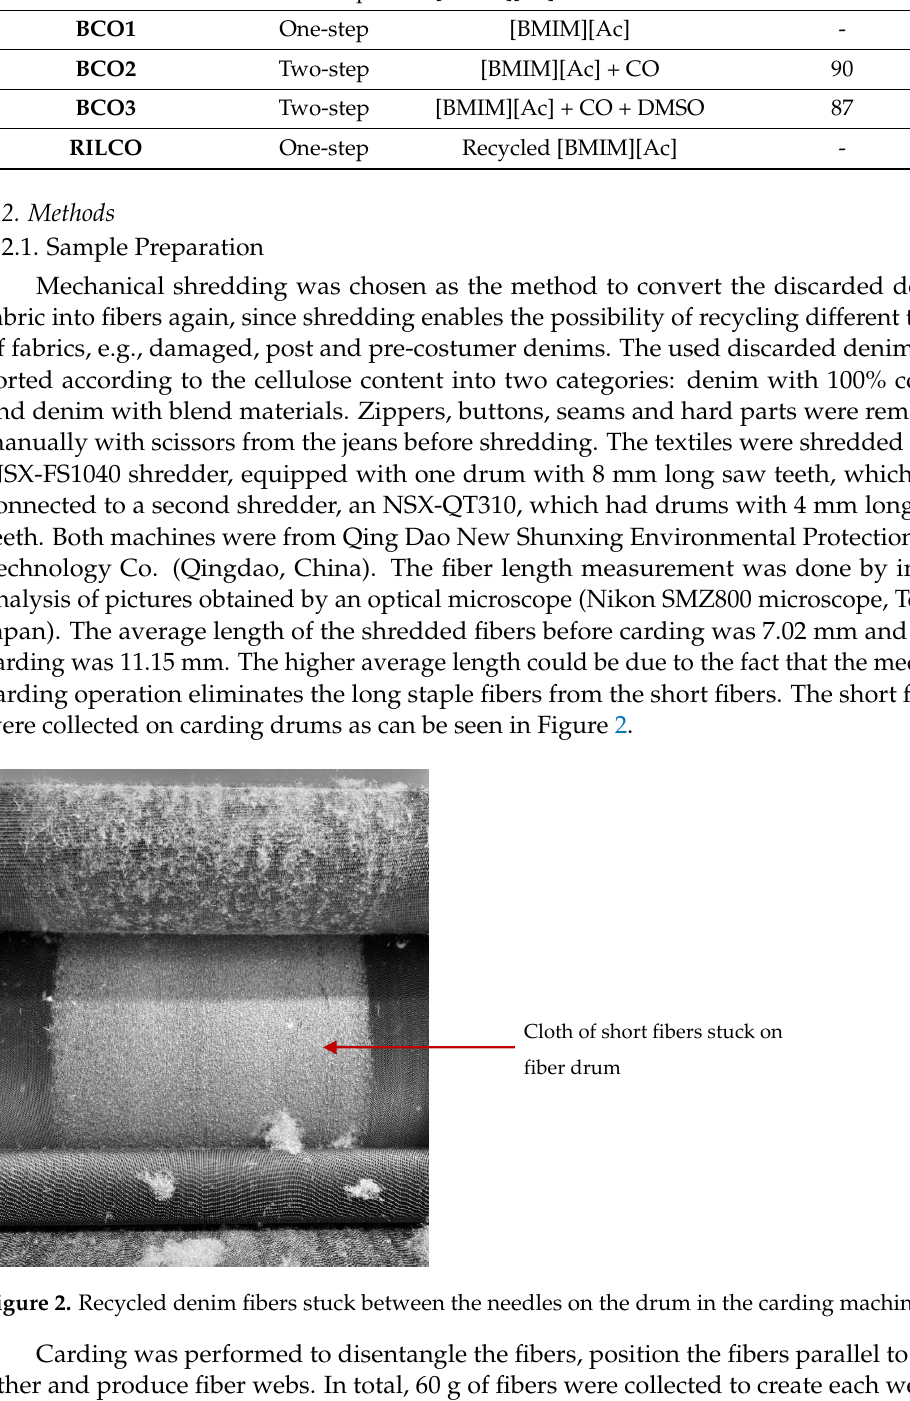
Table 1. Composition of the produced composites.